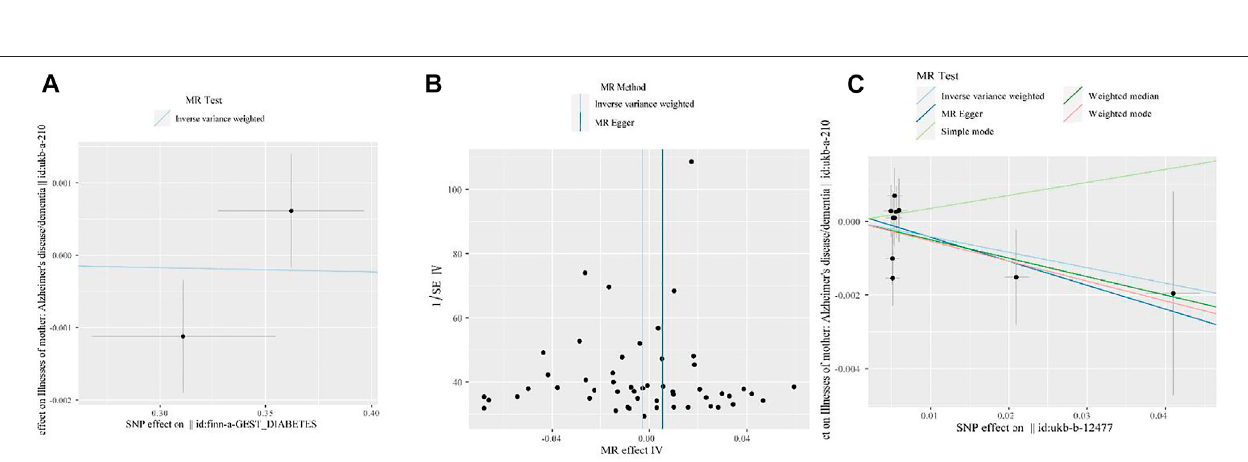
FIGURE2| Resultsof “ leave-one-out ” sensitivityanalysisoftheassociationbetweenhighBMI,HD,andmaternaldementiaintwo-sampleMRanalysis. (A) Results for the association between high BMI and maternal dementia. (B) Results for the association between HD and maternal dementia. Each black line represents the MR effectaftereliminatingeachSNPata95%con fi denceinterval.Eachblackpointrepresentsthemedianvalue(thatis,the β value)acrosseachblackline.Theredlineatthe bottom represents the total MR effect in the sensitivity analysis.